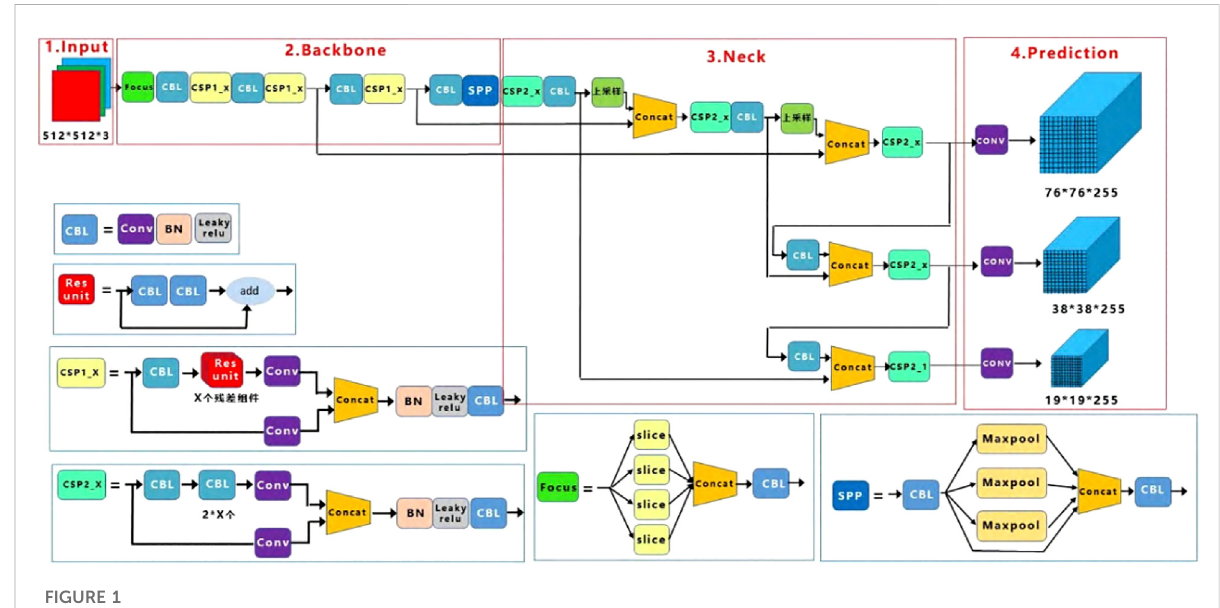
FIGURE 1 The overall algorithm structure of YOLOv5.